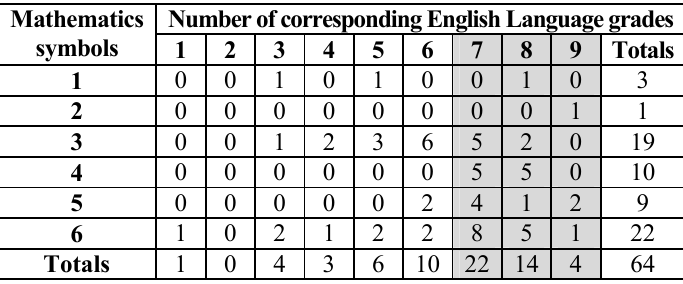
Table 2: A comparison of the 2006 English Language and